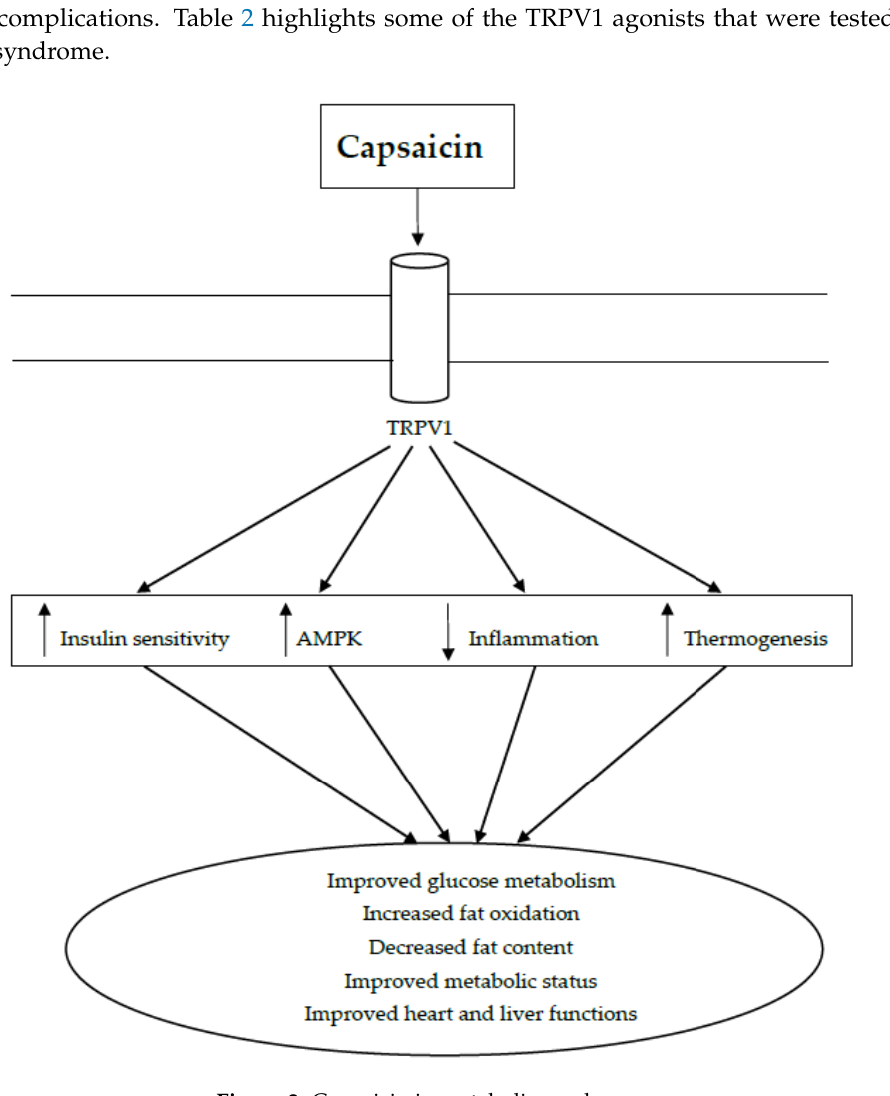
Figure 2. Capsaicin in metabolic syndrome.